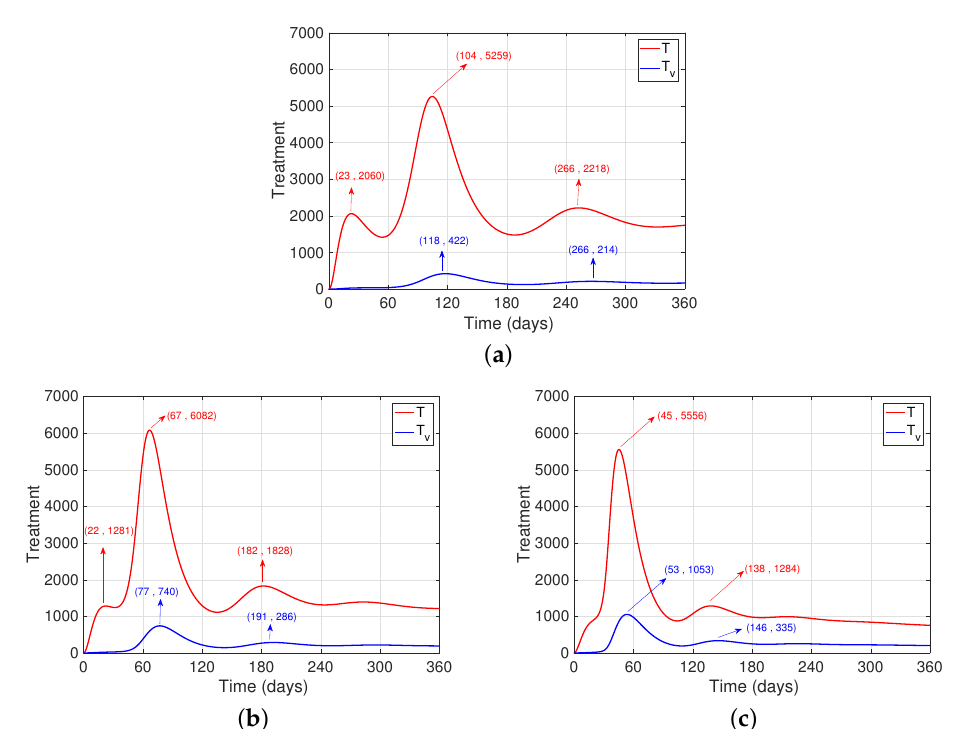
Figure 3. Dynamics of people who need some intervention after varying the vaccination rate. It is observed for the unvaccinated ( T ) and the vaccinated ( T v ). ( a ) Base case. ( b ) Application of the double dose of daily vaccines. ( c ) Quadruplication of daily vaccine doses.